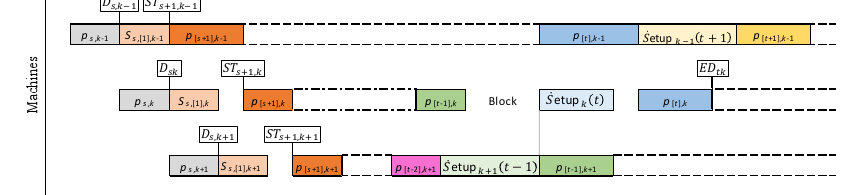
and 𝑆𝑇 representation in a GANTT Fig. 2. 𝐸𝐷 (cid:3047)(cid:3038) (cid:3046)(cid:2878)(cid:2869) , (cid:3038)